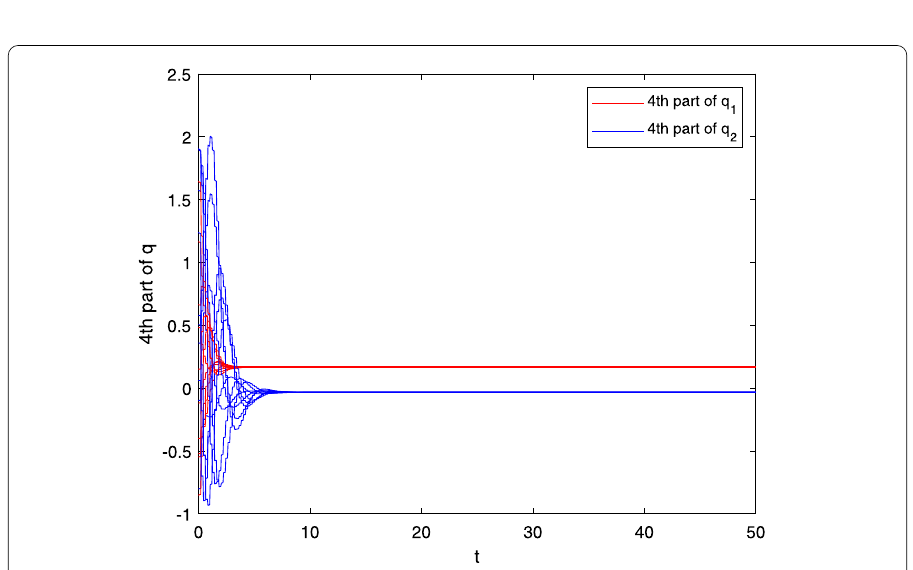
Figure 4 The fourth part of the state trajectories for system (1) with